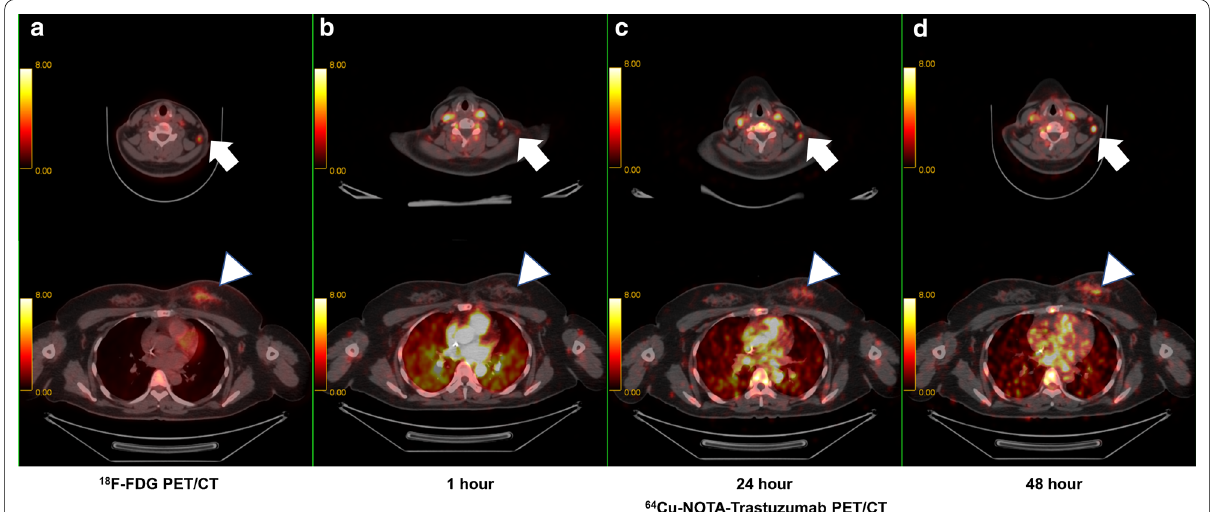
Fig. 5 64 Cu‑NOTA‑Trastuzumab PET images of HER2‑positive breast cancer (arrowheads, lower row) and metastatic lymph node (arrows, upper row). The primary tumor and metastatic lymph nodes were clearly observed by 18 F‑FDG PET/CT ( a ) and 64 Cu‑NOTA‑Trastuzumab PET/CT ( b – d ). In HER2‑expressing lesions, the uptakes of NOTA increased over time to 48 h after